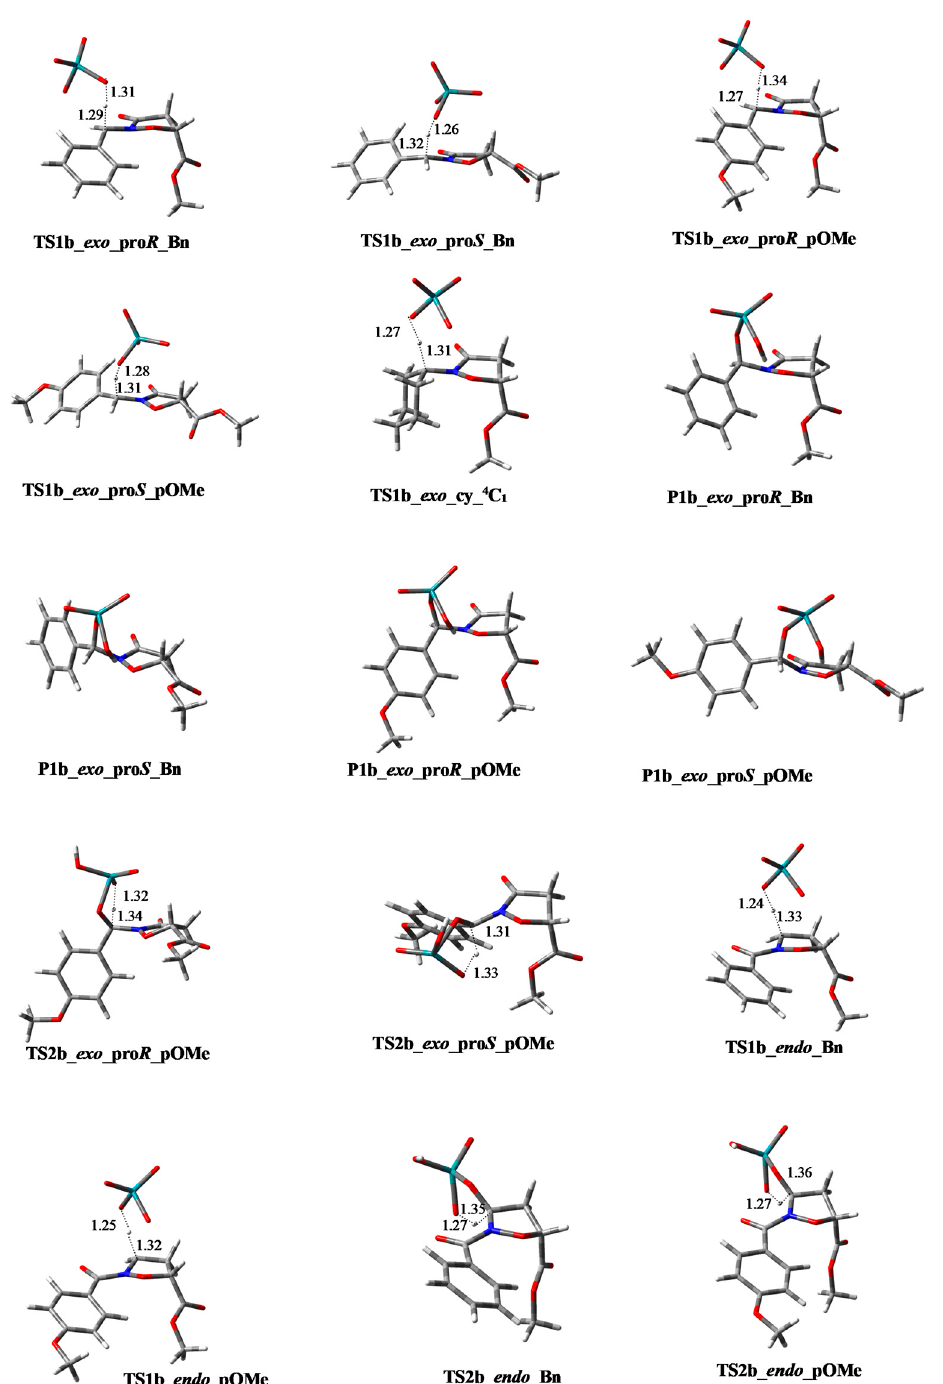
Figure 6. Three-dimensional plots of TSs1–2b and P1 b products. TSs imaginary frequencies are shown as dotted lines and distances are reported in angstroms. Compound 8 can be also obtained by an oxidation process at the endo position of C-3, starting from P2_ exo ( 3a , c ) (Scheme 5). The corresponding calculated barriers are low enough to be surmountable ∆∆ G( TS1 b_ endo) = 17.13, 15.96 kcal/mol; ∆∆ G( TS2 b_ endo) =